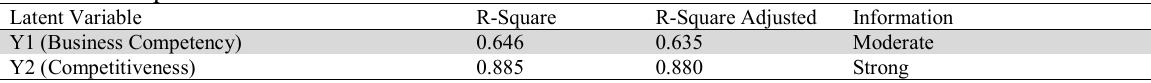
Value of R-Square Variables Latent Variable